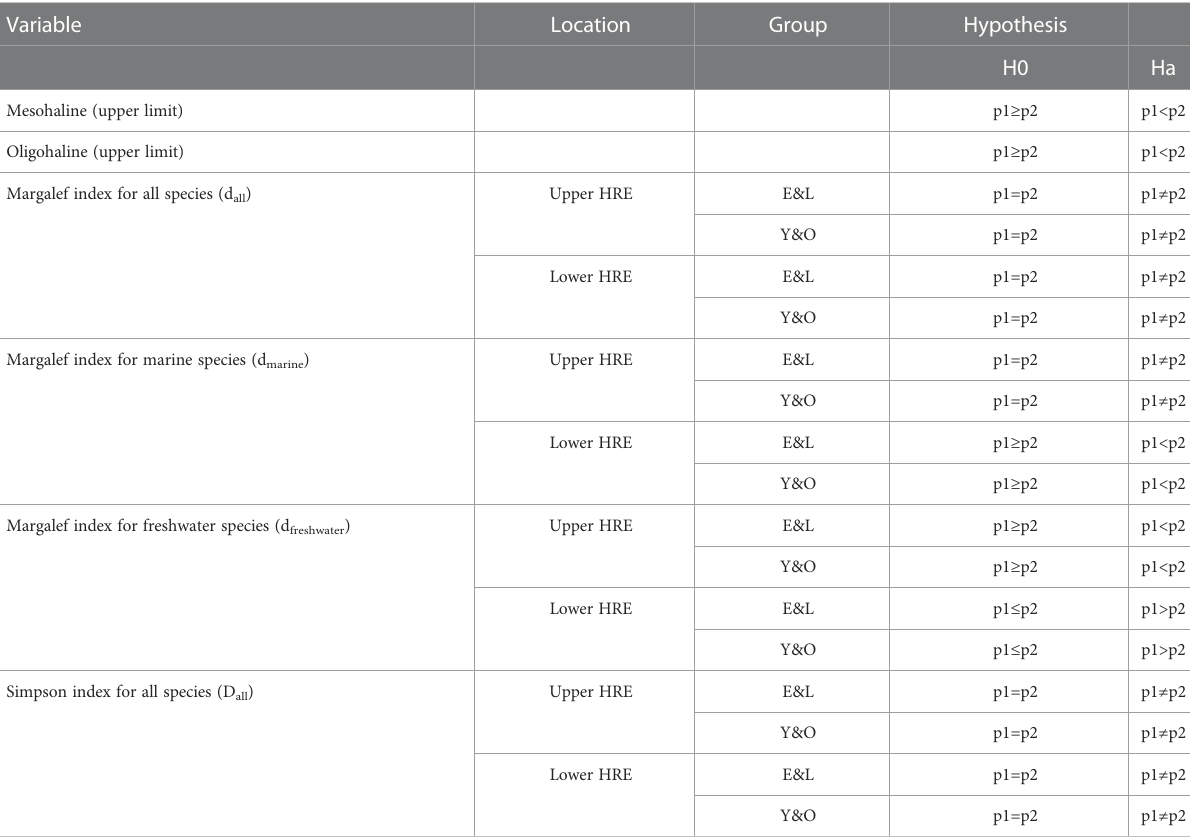
TABLE 1 A series of hypotheses developed for testing the differences between phase 1 (p1, 1974-1984) and phase 2 (p2, 1985-2017) for isohalines, Margalfe index for all, marine, and freshwater species, and Simpson index for all species during May-July in the upper and lower Hudson River Estuary